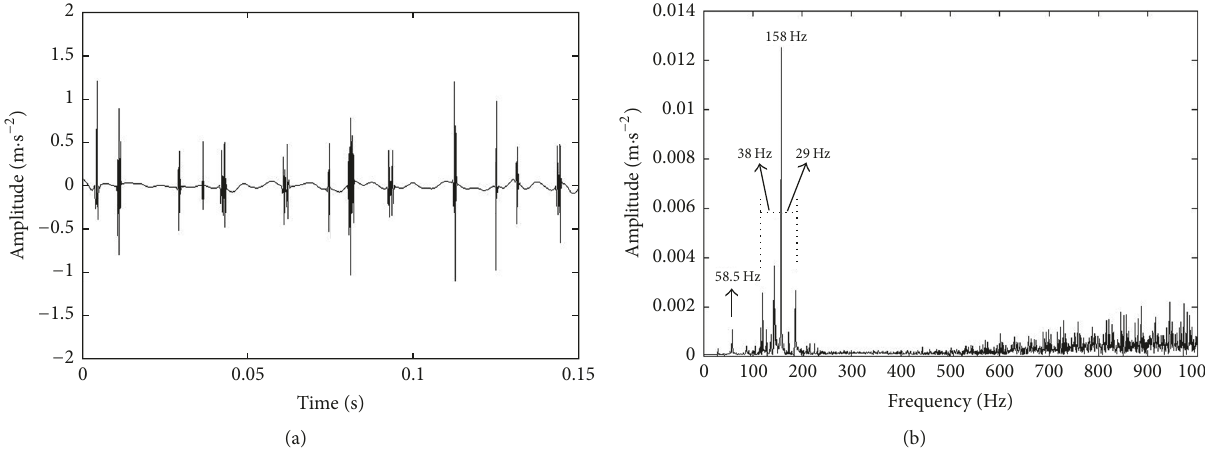
Figure 5: Denoising by hard thresholding technique: (a) waveform in the time domain; (b) frequency